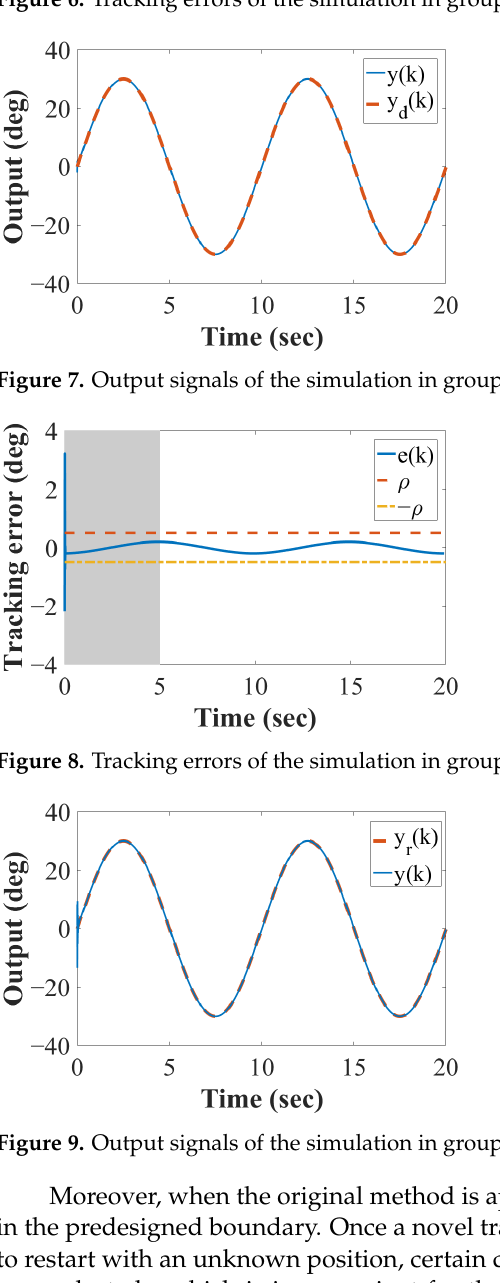
Figure 6. Tracking errors of the simulation in group 1 (original method).